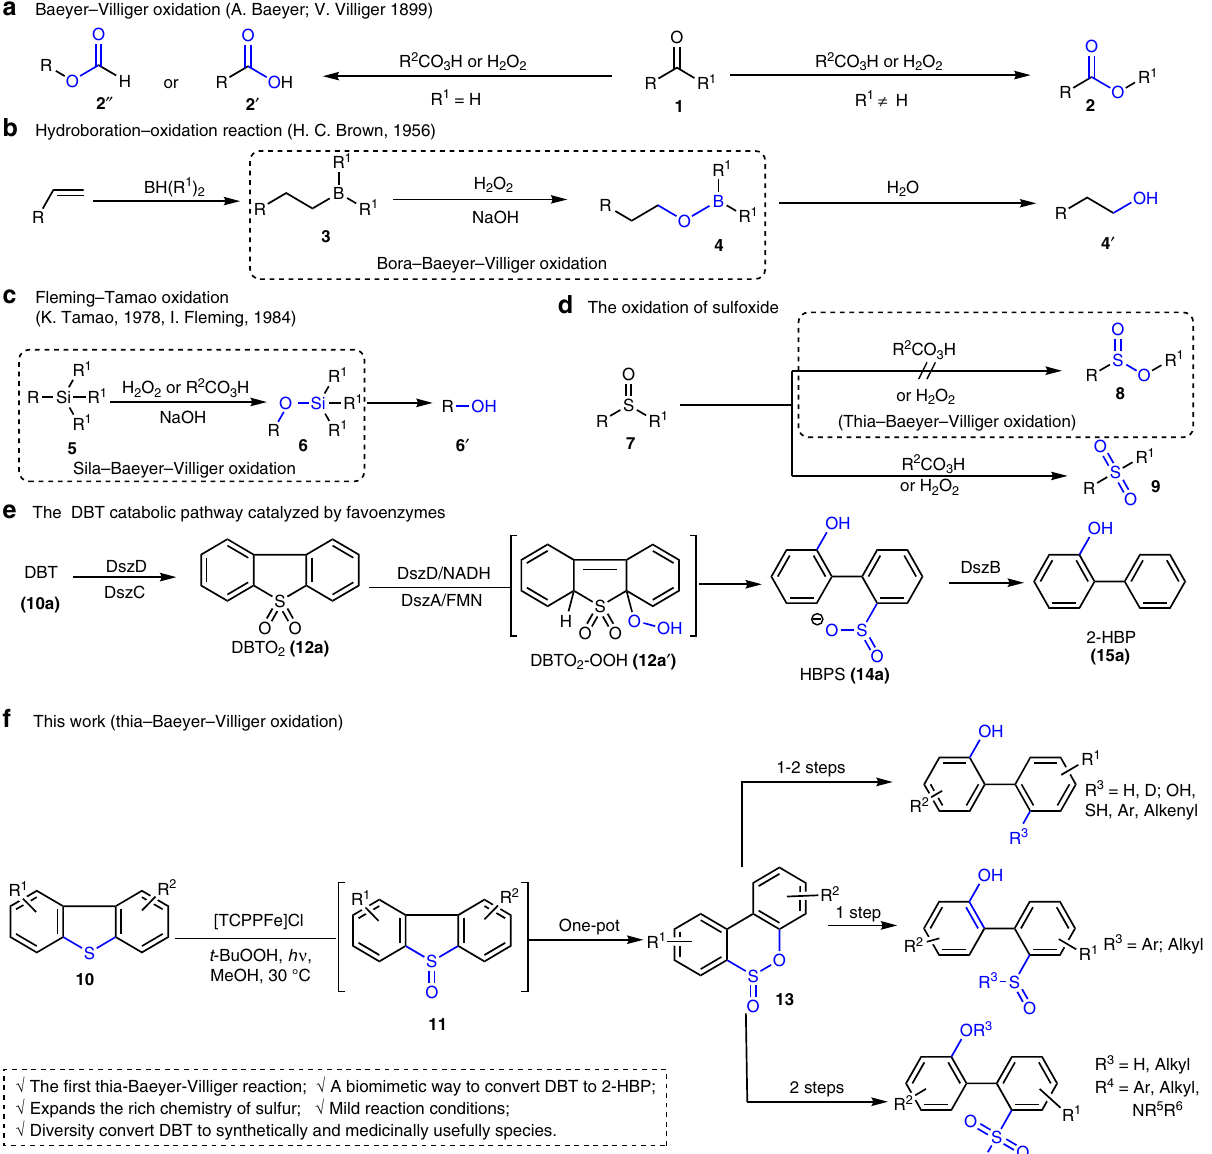
Fig. 1 Examples of oxygen insertion reactions. a Hydroperoxides or peracids promoted Baeyer – Villiger oxidation of ketone or aldehyde, which via oxygen insert to C – C or C – H bond. b Hydroboration oxidation of alkene, in which the last step via oxygen from hydroperoxides insert to C – B bond. c Fleming- Tamao oxidation through oxygen from hydroperoxides or peracids oxygen insert to C – Si bond. d In the presence of hydroperoxides or peracids, sulfoxide – carbon bond cannot take place oxygen insert reaction to produce sul fi nic esters 8 , but formed sulfone 9 via direct oxidation of sulfoxide. e